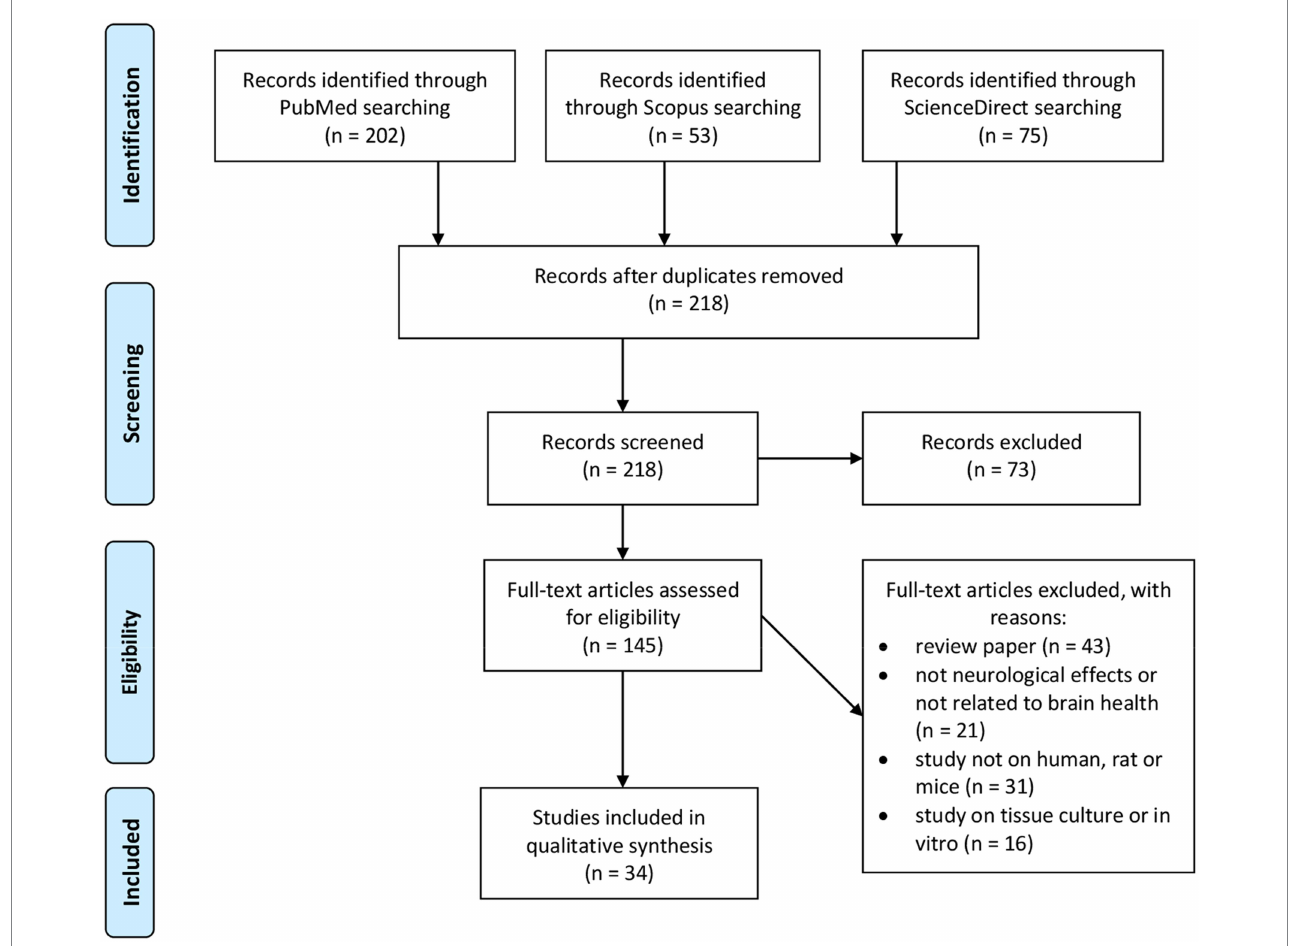
FIGURE 2 Flow diagram of PRISMA statement for inclusion and exclusion criteria at every